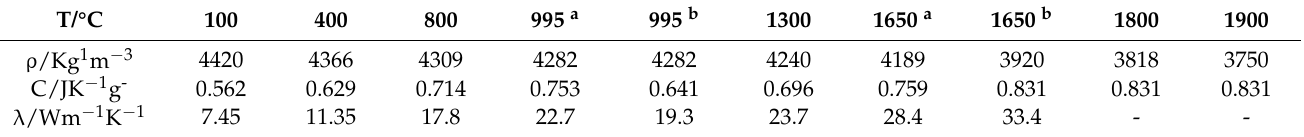
Table 1. The thermo-physical properties of Ti-6Al-4V